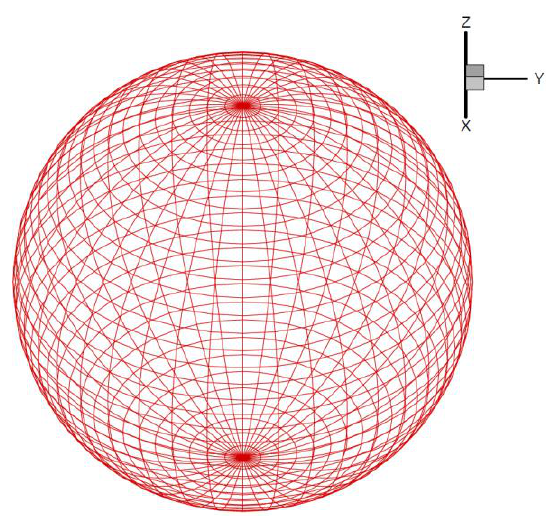
Figure 4. Sphere in an infinite air domain.